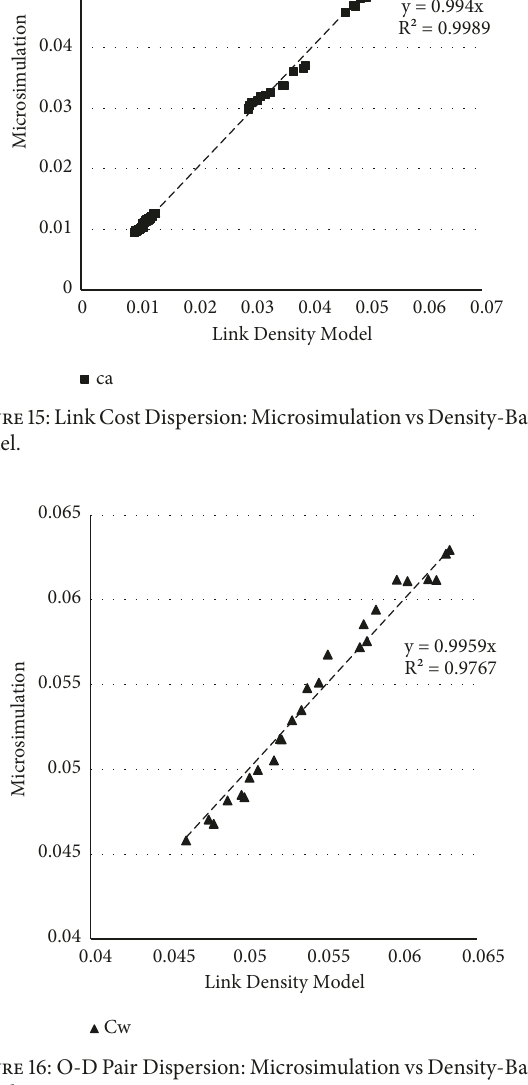
Figure 16: O-D Pair Dispersion: Microsimulation vs Density-Based